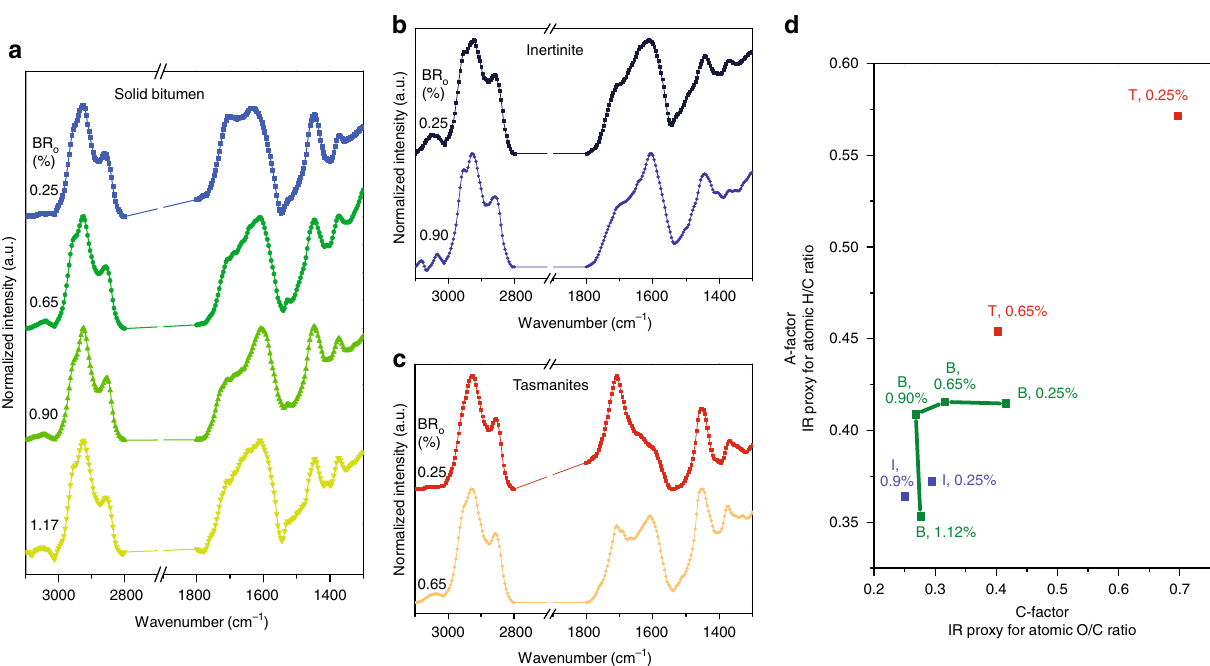
Fig. 4 Compositional trends in the maturation of individual macerals. a Average localized infrared (IR) spectra from three or more different solid bitumen particles in untreated and arti fi cially matured New Albany Shale samples, with solid bitumen re fl ectance (BR o ) ranging from 0.25% to 1.17%. b Average localized IR spectra from different locations in 1 – 2 inertinite particles in samples with BR o of 0.25 and 0.90%. c Average localized IR spectra from different locations in 1 – 2 Tasmanites particles in samples with BR o of 0.25 and 0.65%. d Pseudo van Krevelen diagram, constructed by plotting the IR proxy for H/C and O/C atomic ratios of Tasmanites , solid bitumen, and inertinite at different maturities. Solid bitumen re fl ectance values are indicated adjacent to calculated IR ratios (T, Tasmanites ; B, solid bitumen; and I,